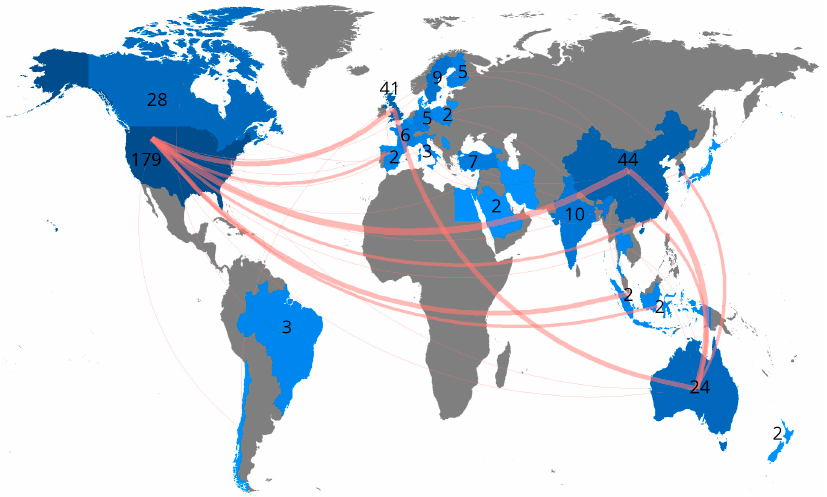
Figure 19. Number of publications per country and collaboration. Software: BiblioShiny version 3.0.